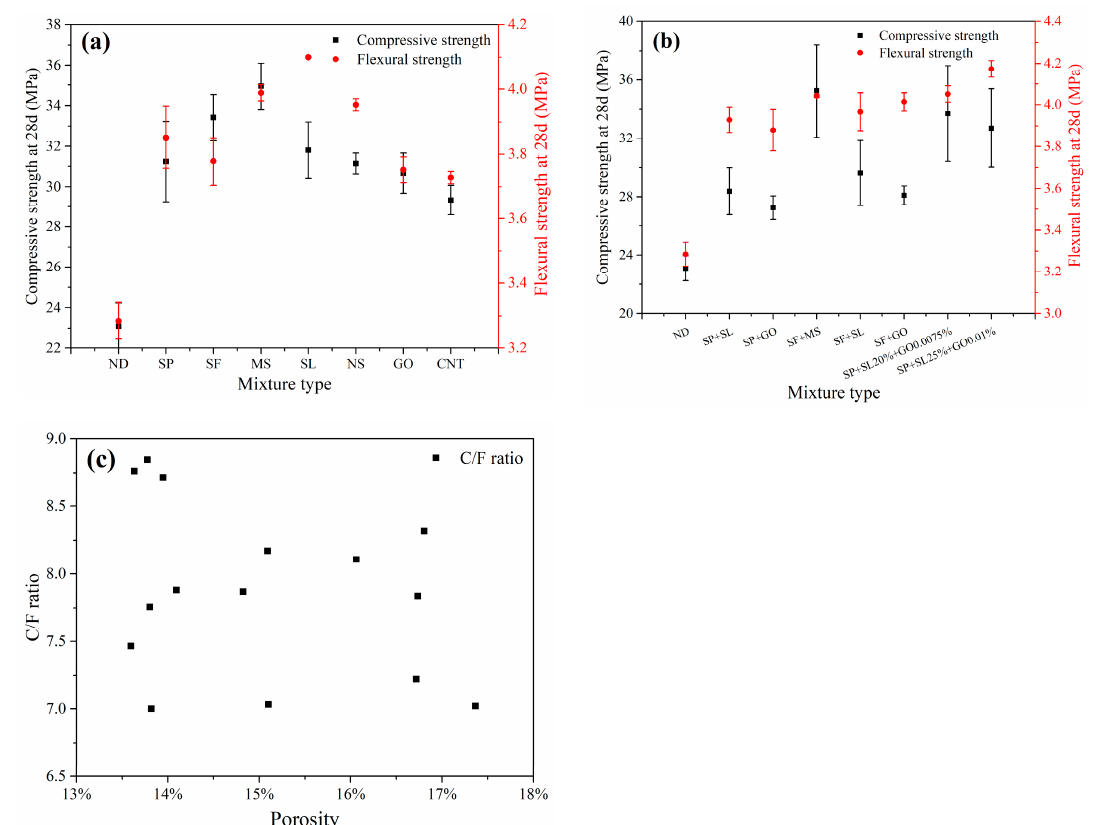
Figure 10. The relationship between compressive strength and flexural strength; ( a ) single admixtures; ( b ) composite admixtures; ( c ) C/F ratio.